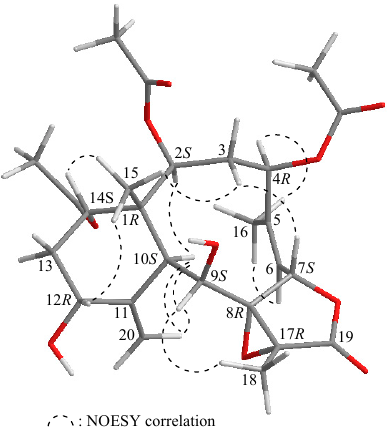
Figure 2. Selected protons with key NOESY correlations of 1 .